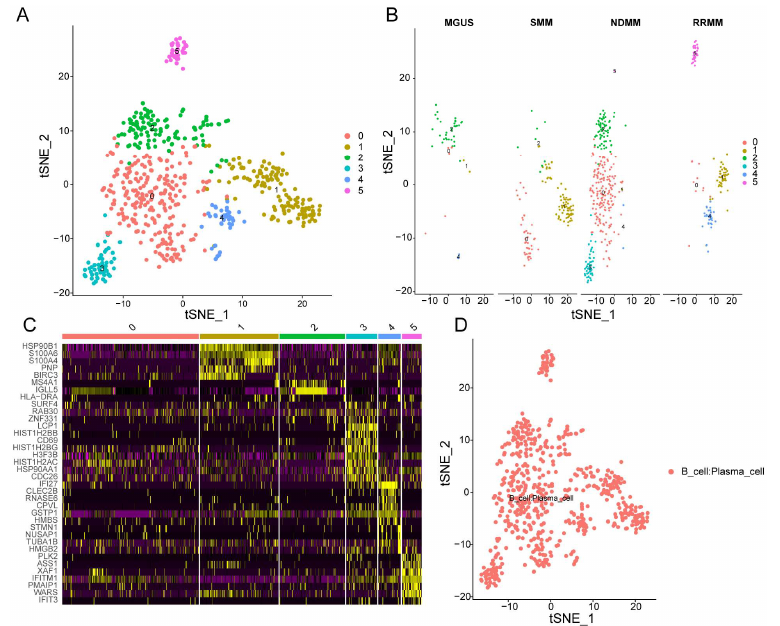
Figure 2. tSNE clustering of single−cell expression profiles. ( A ). tSNE clustering of single-cell transcriptomes colored according to cell−type clusters. ( B ). tSNE clustering of single-cell transcriptomes colored according to different disease stages. ( C ). Heatmap showing the top 5 genes in each cluster. Purple to yellow indicates low to high levels of gene expression. ( D ). Annotation of cell clusters by SingleR and CellMarker database.